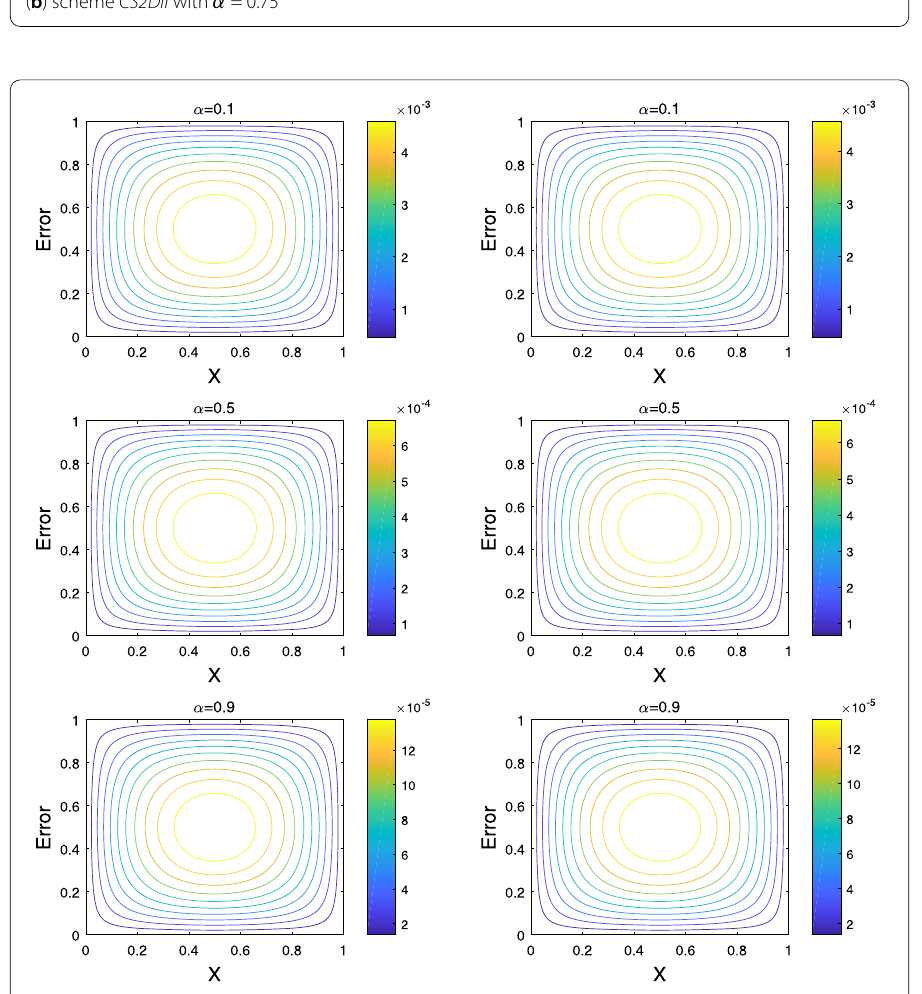
Figure 4 The contour plot of the L ∞ -error using two schemes at T = 1, with N = M = 100, and different α for Example 3. Left panel for scheme CS2DI and right panel for scheme CS2DII , respectively